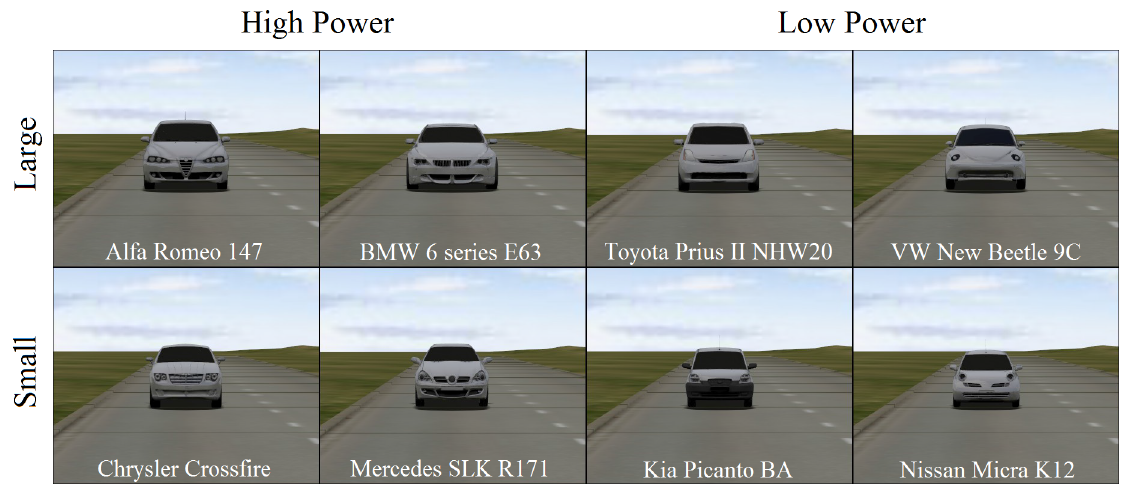
Fig 2. Vehicles used in virtual